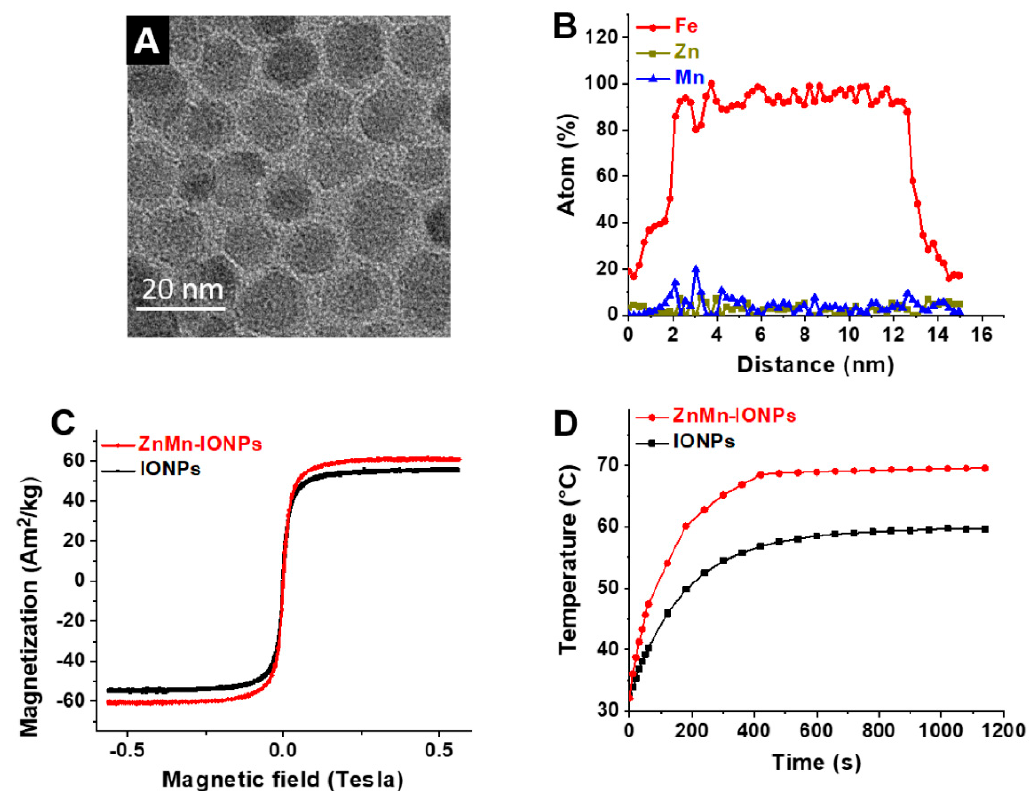
Figure 2. ( A ) Representative TEM image of Zn- and Mn-doped iron oxide nanoparticles (ZnMn-IONPs). ( B ) EDX line scanning profiles of one ZnMn-IONP. ( C ) Magnetization loops of ZnMn-IONPs (red) and IONPs (black) at 300 K. ( D ) Heating curves of ZnMn-IONPs and IONPs (1 mg of Fe/mL in THF) in the presence of an alternating magnetic field (AMF) (420 kHz, 26.9 kA/m).